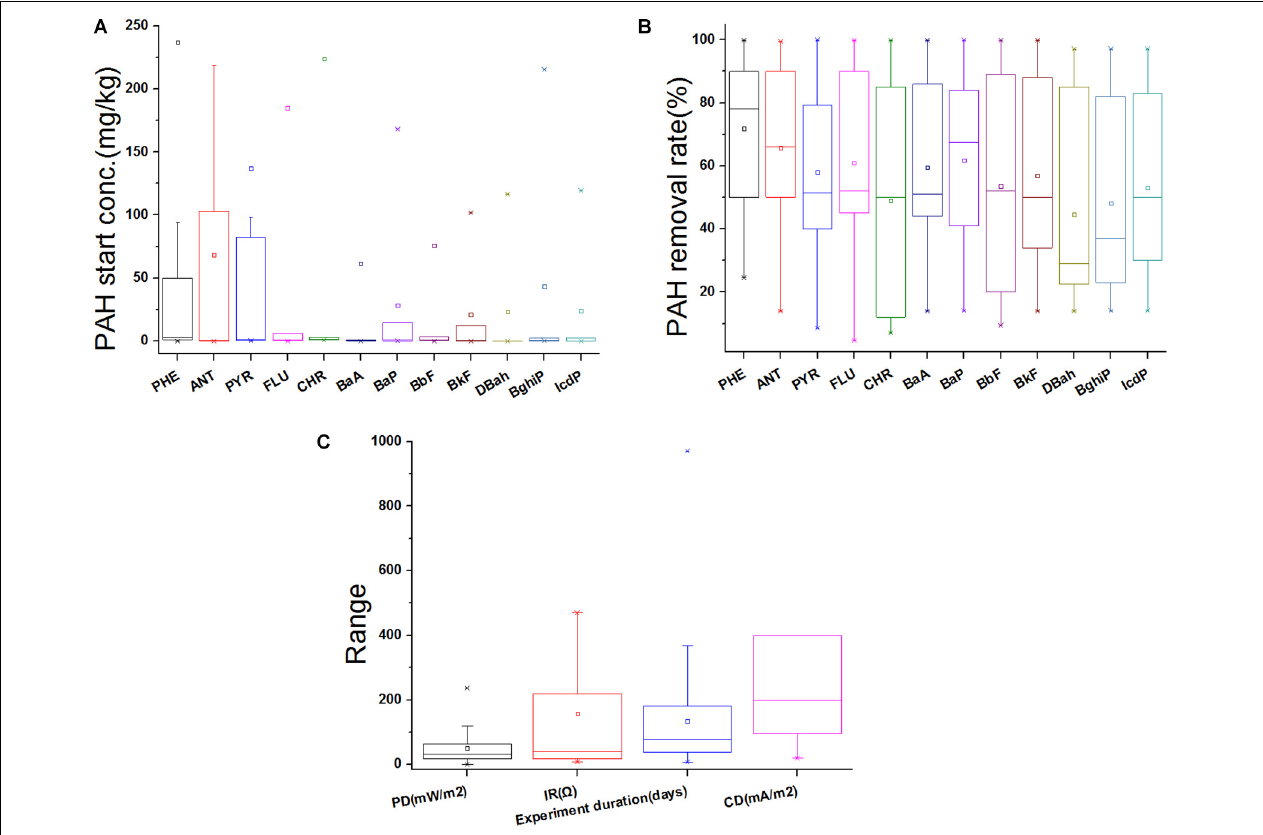
FIGURE 1 | Summary of PAH removal in MFCs. (A) Start concentration of each PAH; (B) Removal rate (%) of each PAH after MFC treatment; (C) power density (PD), current density (CD), internal resistance (IR), and experiment duration reported in recent MFC studies. Boxes represent 25–75% of the data, middle lines the median value, squares the average, and ends represent the minimal and maximal values (1.5 times less or more than the lower or upper quantiles). Outlier is shown in multiplication sign. Three rings PAH: PHE, phenanthrene; ANT, anthracene; Four rings: PYR, pyrene; FLU, fluoranthene; CHR, chrysene; BaA, benzo(a)anthracene; Five rings: BaP, benzo(a)pyrene; BbF, benzo(b)fluoranthene; BkF, benzo(k)fluoranthene; DBah, dibenzo(a,h)anthracene; Six rings: BghiP, benzo(g,h,i)perylene; IcdP,